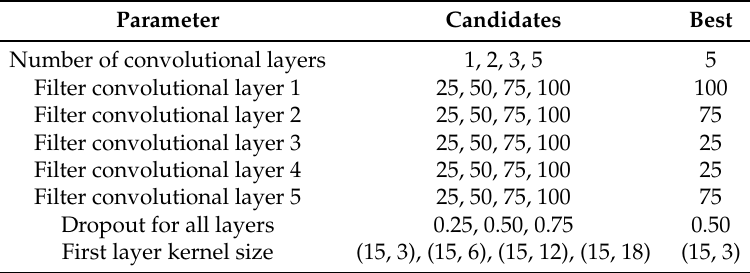
Figure 5. Neural network architecture for recognition and counting. Windows of raw sensor data from up to six sensors are passed through several convolutional layers, before a fully connected layer with a softmax activation outputs the final predictions. Table 3. Parameters of the grid search for the recognition model.